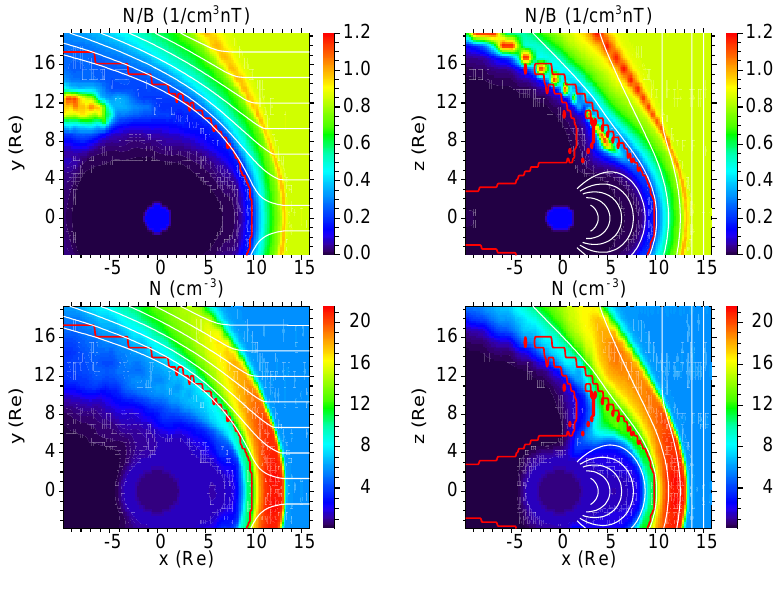
Fig. 1. The utility of the N/B ratio to mark the outer boundary of the plasma depletion layer. Shown here are the global model results with the baseline solar wind conditions as input. The left panels show the results in the GSE z=0 plane, and the right panels show the results in the GSE y=0 plane. The N/B values are shown as the background on the top panels, and the plasma density values are shown as the background on the bottom panels. The open-closed magnetic field boundary is shown as a red zigzag curve in each of the panels. The flow lines are shown as white smooth curves in the left panels, and magnetic field lines are shown as white smooth curves in the right